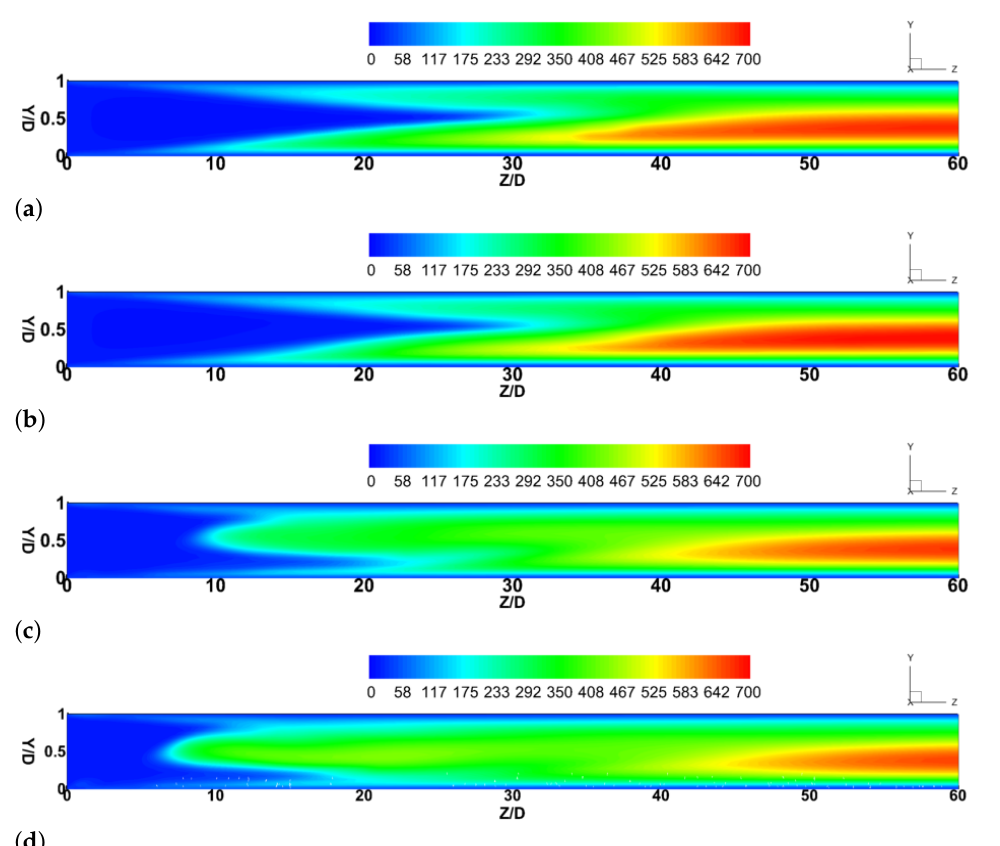
Figure 6. Contours of turbulent viscosity ratio ( µ t / µ o ) in the middle plane: ( a ) SR = 0; ( b ) SR = 0.1; ( c ) SR = 0.25; ( d ) SR =